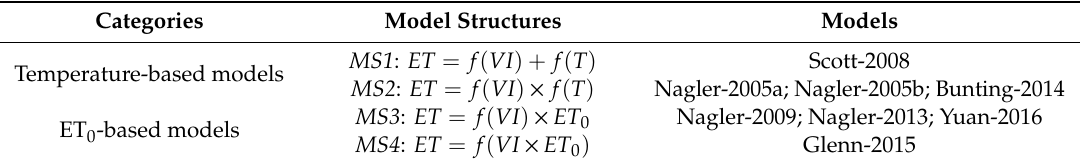
Table 5. Model structures of the eight ERSETMs compared in this